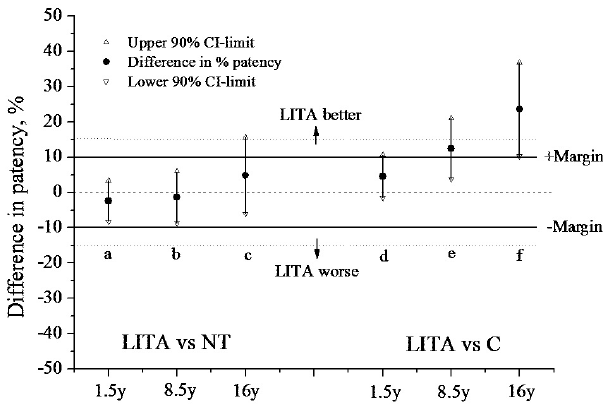
Fig. 1 – Differences in patency, left internal thoracic artery (LITA)